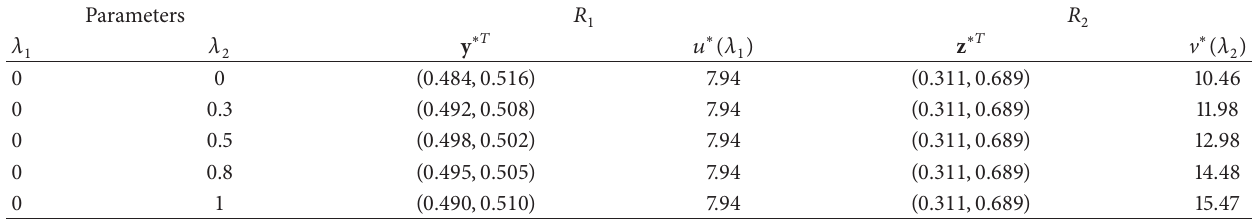
Table 1: Satisfying Nash equilibrium values and corresponding strategies of commerce retailers.